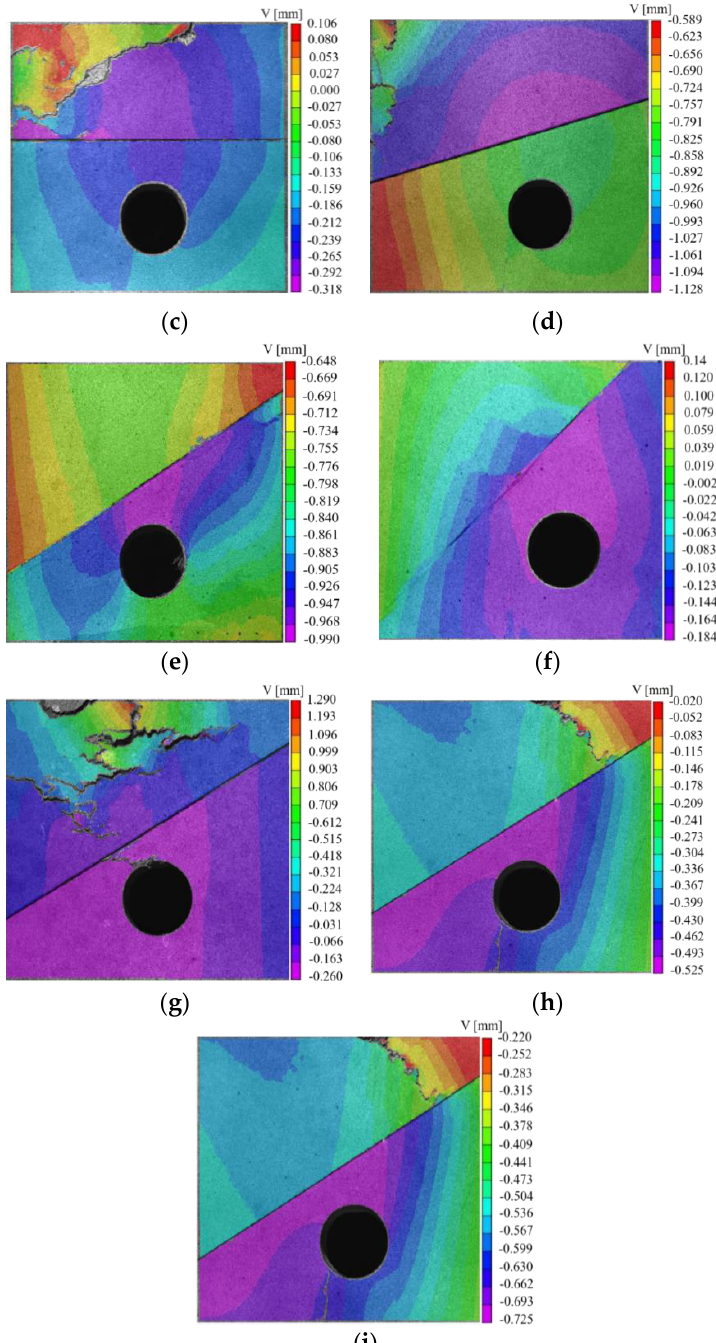
Figure 23. Nucleation phenomena of different types of granite samples; ( a ) Sample C (99.2%); ( b ) Sample O (97.5%); ( c ) Sample A-0 (96.2%); ( d ) Sample A-15 (99.3%); ( e ) Sample A-30 (94.6%); ( f ) Sample A-45 (96.6%); ( g ) Sample L-1 (99.8%); ( h ) Sample L-2 (98.9%); ( i ) Sample L-3 (98.3%). The vertical displacement image of the granite sample with a hole is shown in Figure 23a. The phenomenon of displacement nucleation appeared below the hole, indicating that the microunits below the hole all moved downward. The vertical displacement images of granite samples with bonded fractures of 0°, 15° and 30°, 45°, and unbonded fractures are shown in Figure 23b – d. The red to purple in the legend indicates that the displacement value increased downward. Figure 23 shows that there was a purple nuclear displacement zone between the fracture and the hole, which meant that the vertical